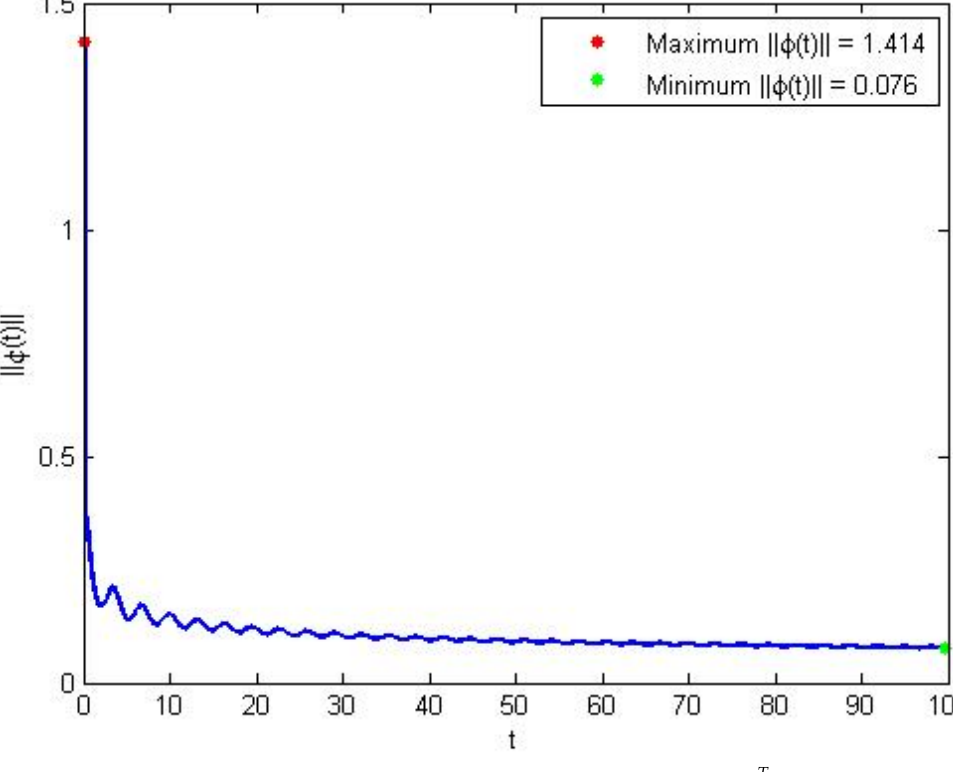
Figure 16. || ϕ ( t ) || for system (10), with α = 0.5, ρ = 0.5, and w ( t ) = [ 2 sin ( t )] T Figure 16. ‖𝜑(𝑡)‖ for system (10), with 𝛼 = 0.5 , 𝜌 = 0.5, and 𝑤(𝑡) = [2 𝑠𝑖𝑛(𝑡)] 𝑇 .